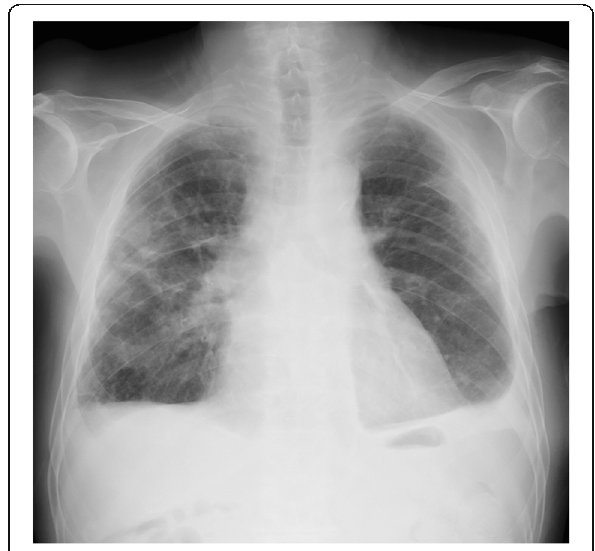
Fig. 4 Postoperative chest radiograph showing full expansion of the